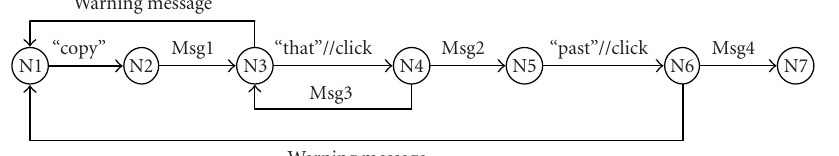
Figure 5: Example of modeling semantic speech and mouse-clicking an interaction message: (“copy” + (“that” // click) + (“paste” // click)). Symbols + and // stand for serial and concurrent messages in time. All output arcs are labeled with messages presented in output modalities, while input ones correspond to user actions. The warning message is used to inform, ask, or warn the user when he stops interacting with the system. (Msg: output message of the system, N: node representing a state of the system.)